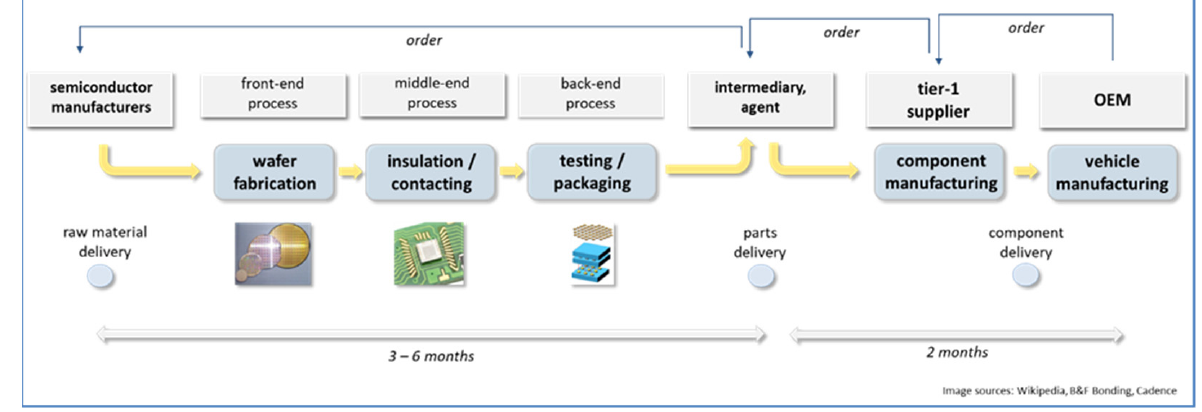
Figure 4. Production and supply chain for semiconductor components [18].